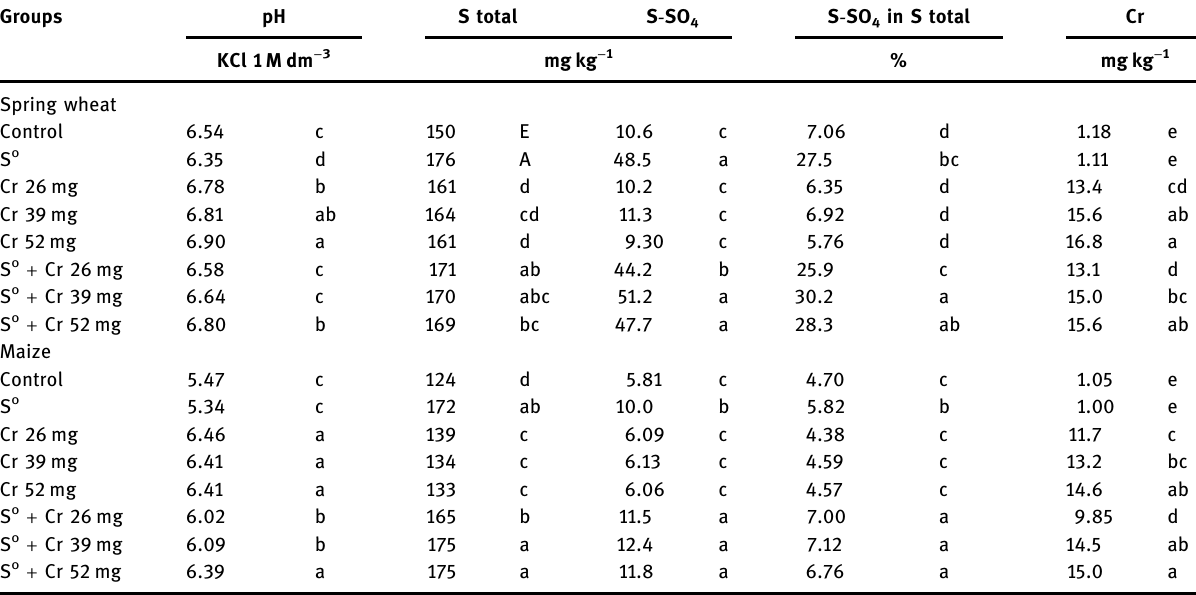
Table 7: Soil pH and the content of S total, sulfates ( VI ) , and Cr in the soil Groups pH S total S - SO